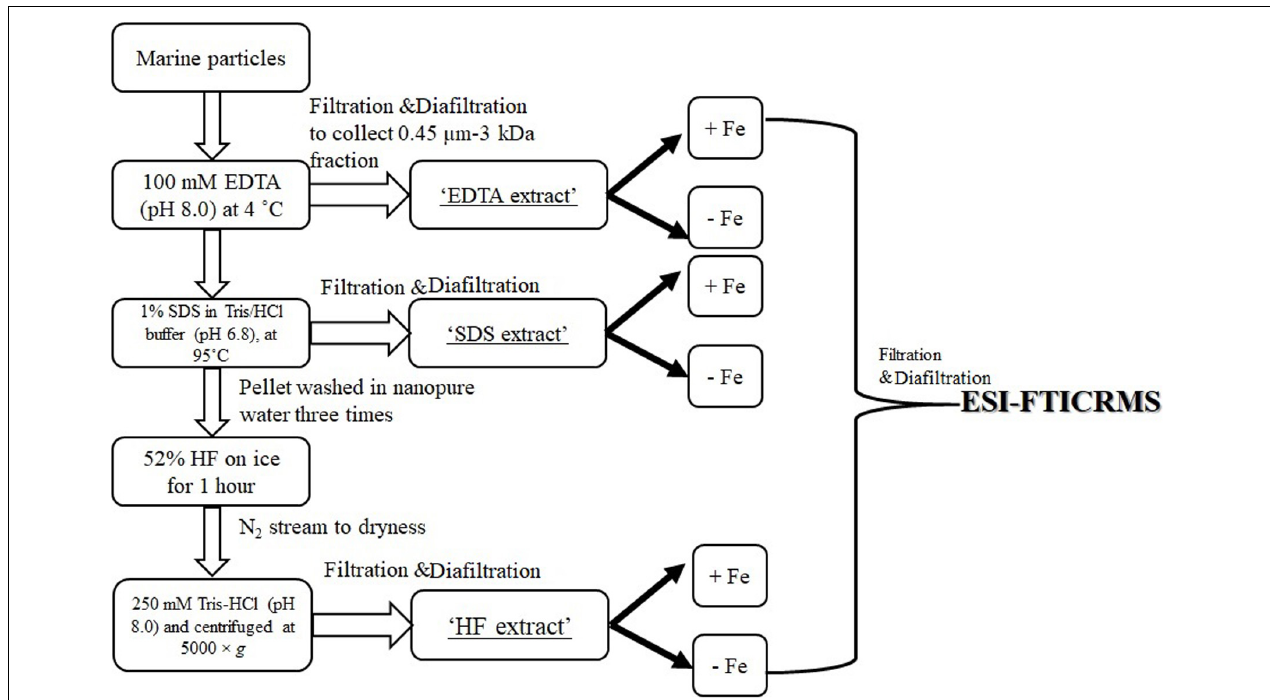
FIGURE 1 | Flow chart of sequential extraction and electrospray ionization (ESI) Fourier-transform ion cyclotron resonance mass spectrometry (FTICRMS) analysis.